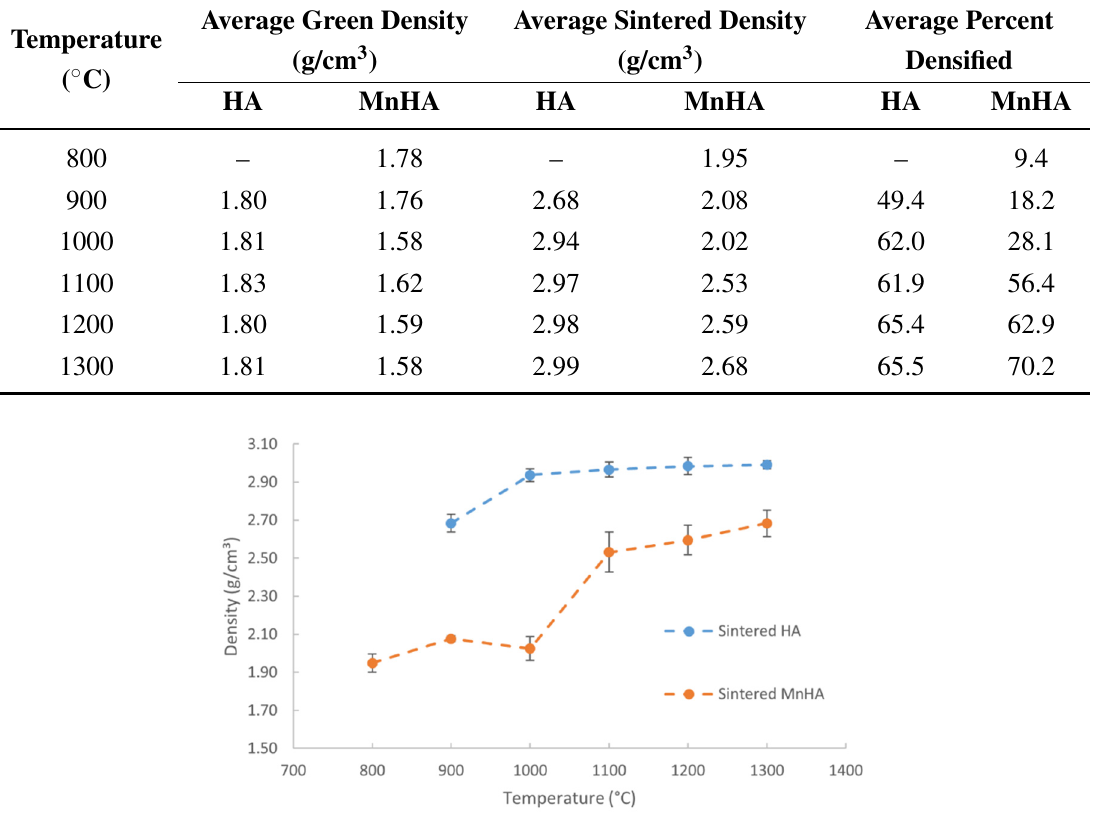
Figure 5. Densities of sintered HA and MnHA pellets as a function of temperature. Average densities are plotted ± standard deviation ( n ≥ 4). Table 1. Average density values of green and sintered bodies and percent densification for each studied temperature point.